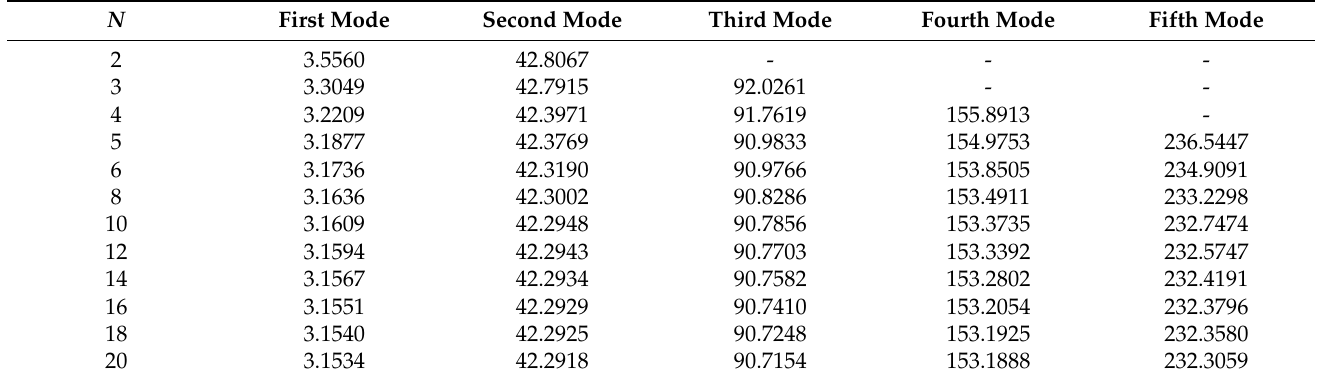
Table 2. Convergence characteristics of the dimensionless chordwise vibration frequencies when δ = 0 , α = 70, ϕ = 1, and γ =